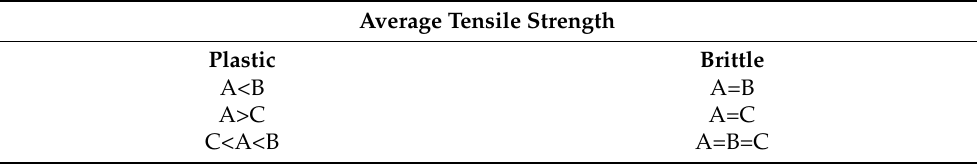
Table 7. Compressibility behavior of excipients from tensile strength determinations according to Wells